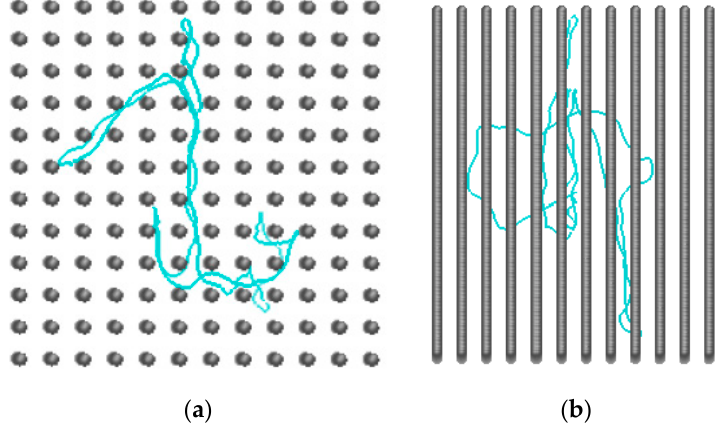
Figure 2. Snapshot of a semiflexible circular chain in an array of nanoposts with d p = 4.9 and S p = 12: top view ( a ); and side view ( b ). Table 1. Geometrical parameters of post arrays as defined in the text in the simulation length units; 1 unit ≈ 2.5 nm.